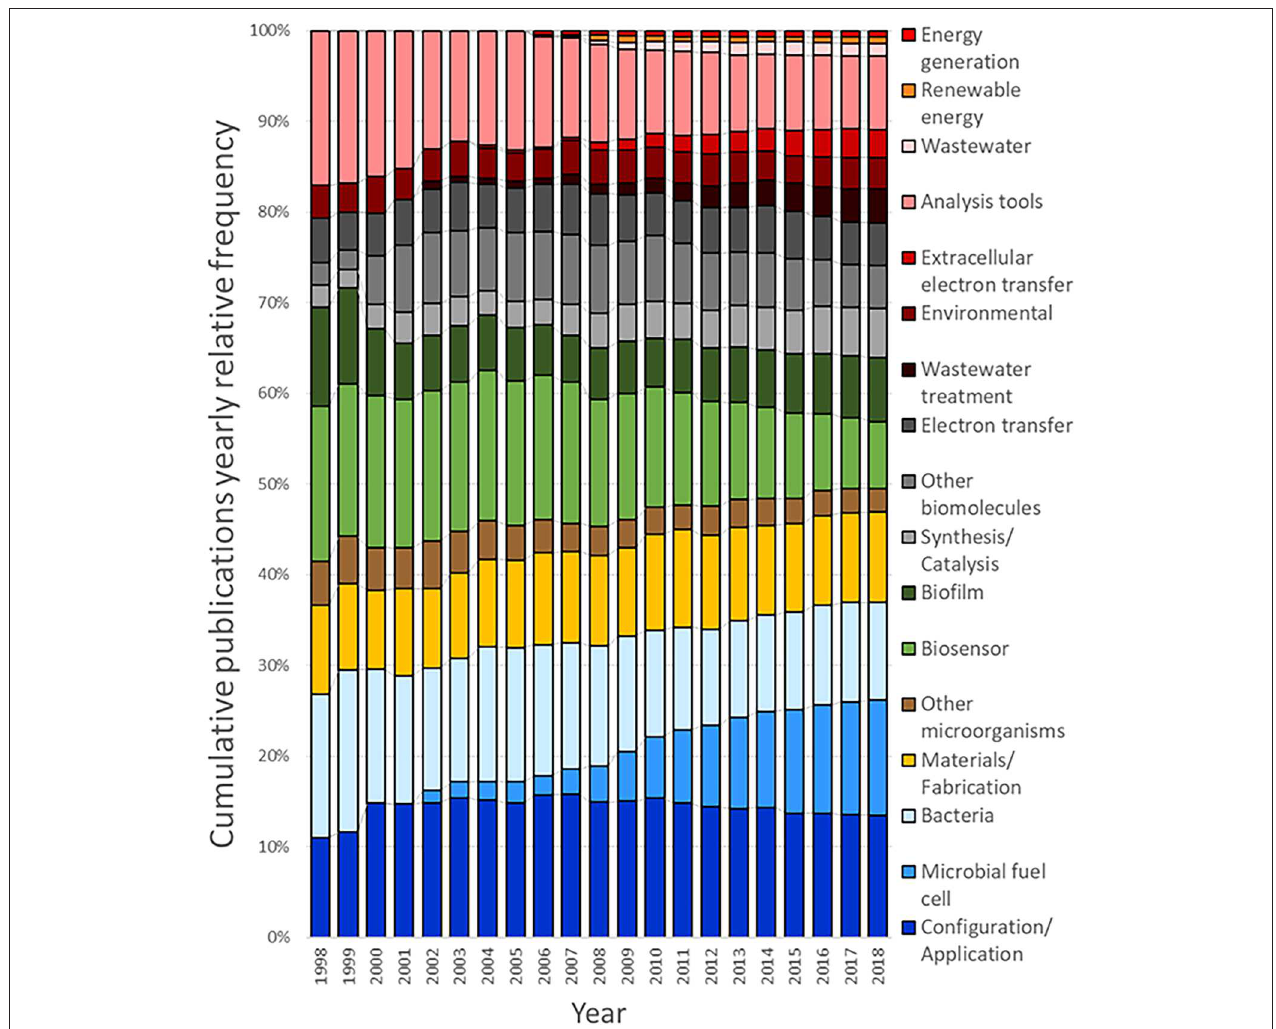
FIGURE 9 | Cumulative publications for selected research areas yearly relative